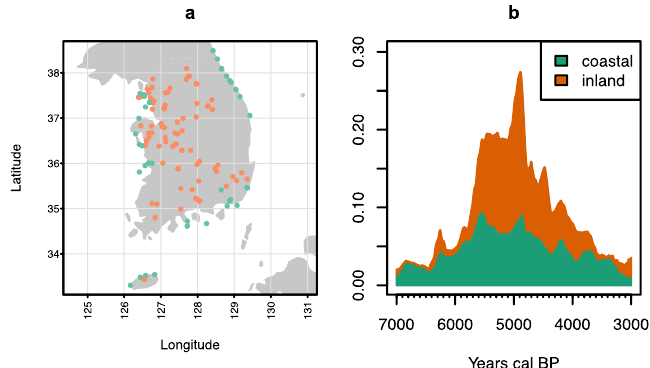
Figure 1. Distribution of sampling location of 14 C dates ( a ) and summed probability distribution of the coastal and inland regions ( b ). Figure generated using R v4.1.0 (https:// www.r- proje ct. org/), basemap from GADM (https:// gadm.